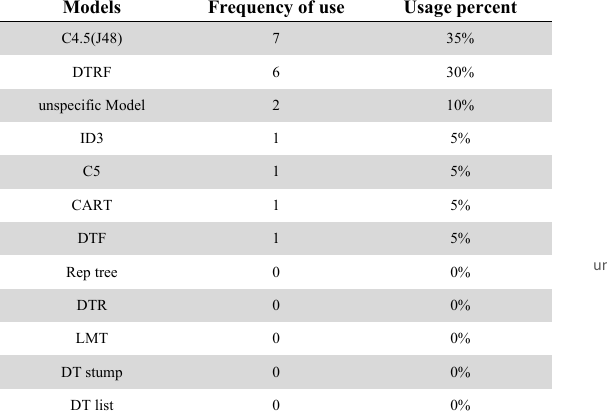
Comparison of the Decision Tree models